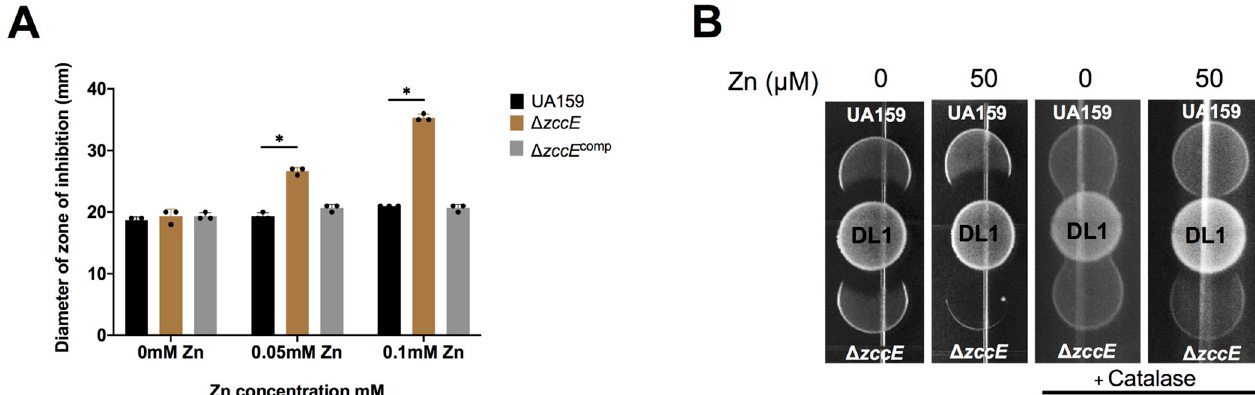
Fig 9. Disruption of Zn homeostasis increases H 2 O 2 sensitivity in the zccE strain. (A) Growth inhibition zones for S . mutans UA159, Δ zccE , and Δ zccE Comp strains grown on BHI agar with or without Zn supplementation and exposed to filter paper discs saturated with 0.25% H 2 O 2 . Two-way ANOVA was used to determine significance ( � , p < 0.05). (B) Growth inhibition zones of S . mutans UA159 and Δ zccE strains by peroxigenic S . gordonii DL-1 spotted on BHI agar with or without 50 μ M Zn supplementation. The S . mutans - S . gordonii competition assay was repeated with catalase overlaid onto the S . gordonii spot to inactivate H 2 O 2 . Images are representative of results from three independent experiments.